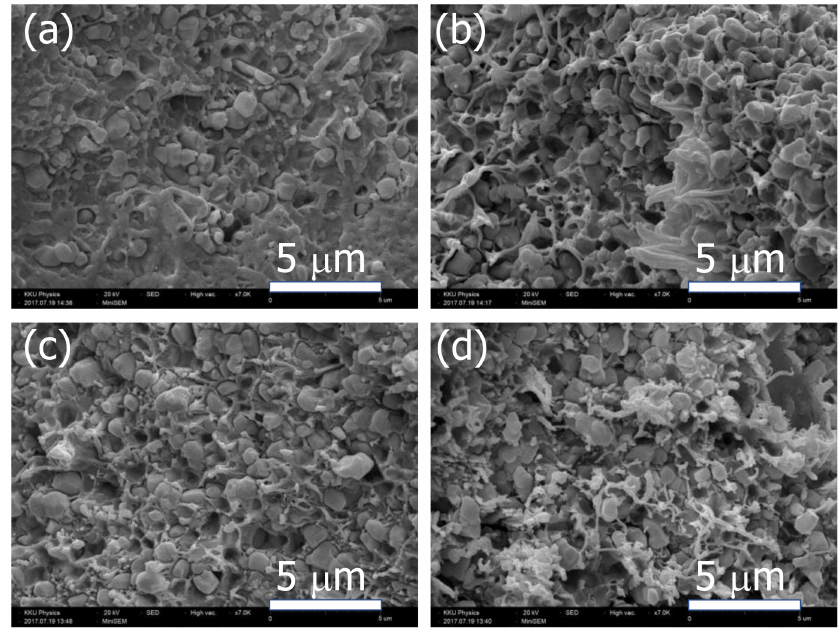
Figure 3. SEM images of Ag − INTO/PVDF composites with different f Ag − INTO values: ( a ) f Ag − INTO = 0.1, ( b ) f Ag − INTO = 0.3, ( c ) f Ag − INTO = 0.4, and ( d ) f Ag − INTO =